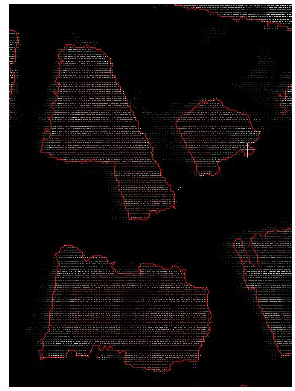
Figure 4: Individual buildings with roofs